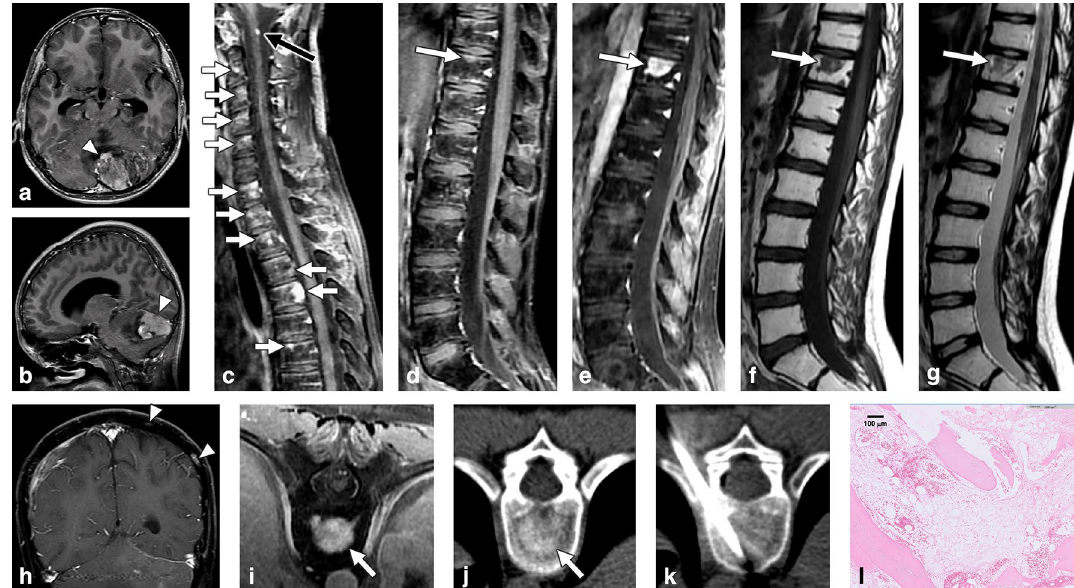
Figure 2. Indolent enhancing spinal lesion (IESL)—Case 2. An 11-year-old boy with medulloblastoma of the cerebellum ( a , b ) had undergone surgical resection and chemoradiotherapy. Sagittal contrast-enhanced T1WI revealed multiple enhancing foci in the cervical to thoracic spine 15 months after the diagnosis ( c , d ). Focal leptomeningeal seeding was noted at the C1 level ( c , black arrow). In the follow-up MRI 33 months after brain tumor surgery, sagittal contrast-enhanced T1WI revealed significantly progressive changes in the lesion at vertebrae T11 with a target enhancement pattern ( e , arrow). The lesion exhibited hypointensity on T1WI ( f ) and hypointensity on T2WI ( g ). Several enhancing lesions were also present at the temperoparietal skull bone of the brain MRI ( h ). On axial images, the T11 lesion had strong enhancement on contrast-enhanced MRI T1WI ( i ) and osteoblastic changes on the CT scan ( j ). CT-guided biopsy of the T11 lesion showed mild marrow fibrosis, adipose tissue filled in the marrow spaces, and scattered hematopoietic cells (H&E staining) ( k , l